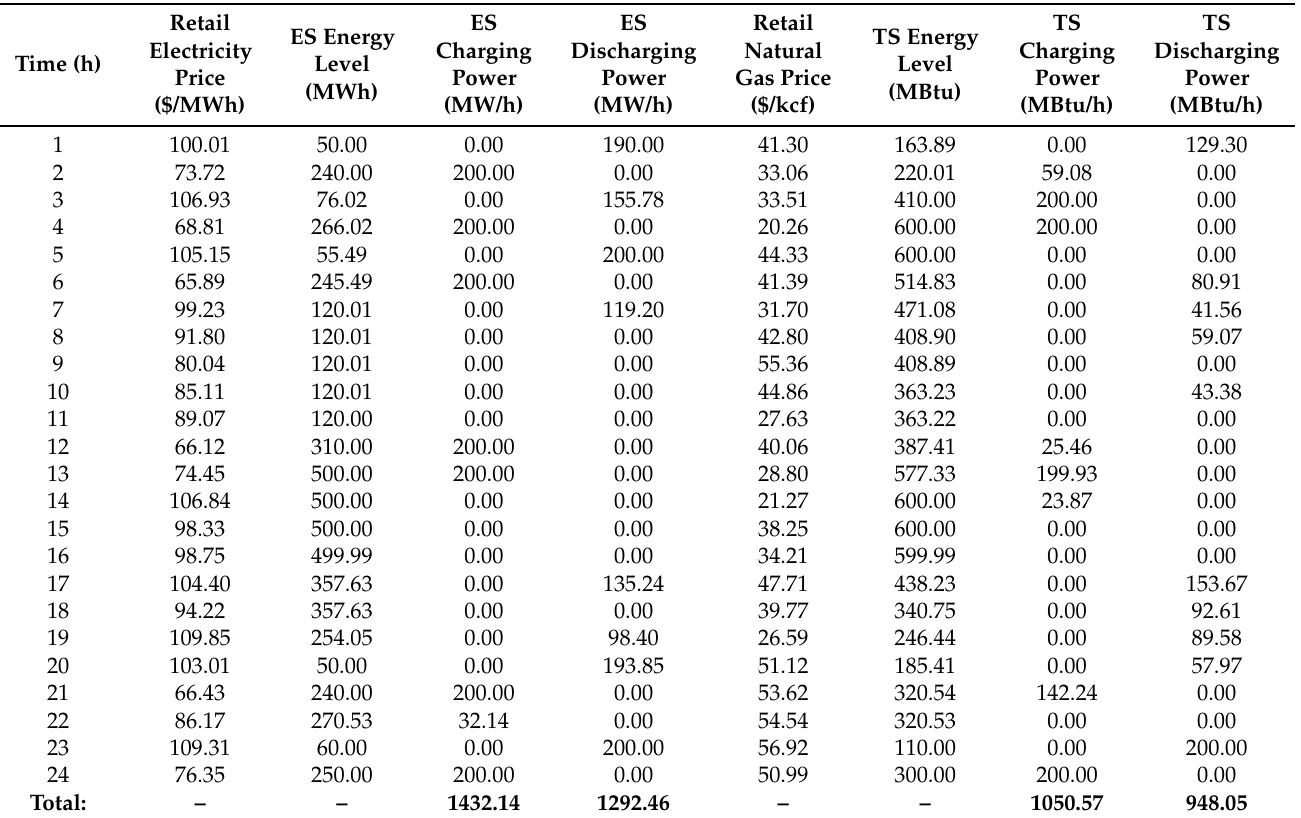
Table 8. ES and TS results for microgrid 2. – : Not